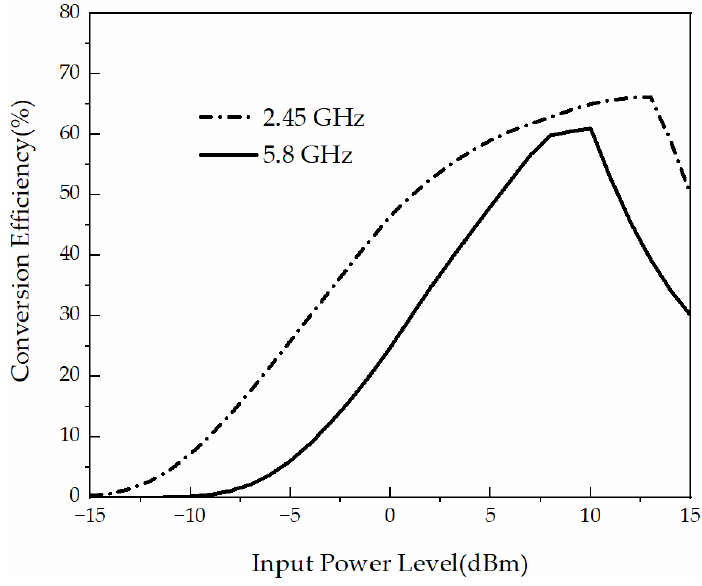
Figure 18. Measured conversion efficiency (load resistance is 2 K Ω ).